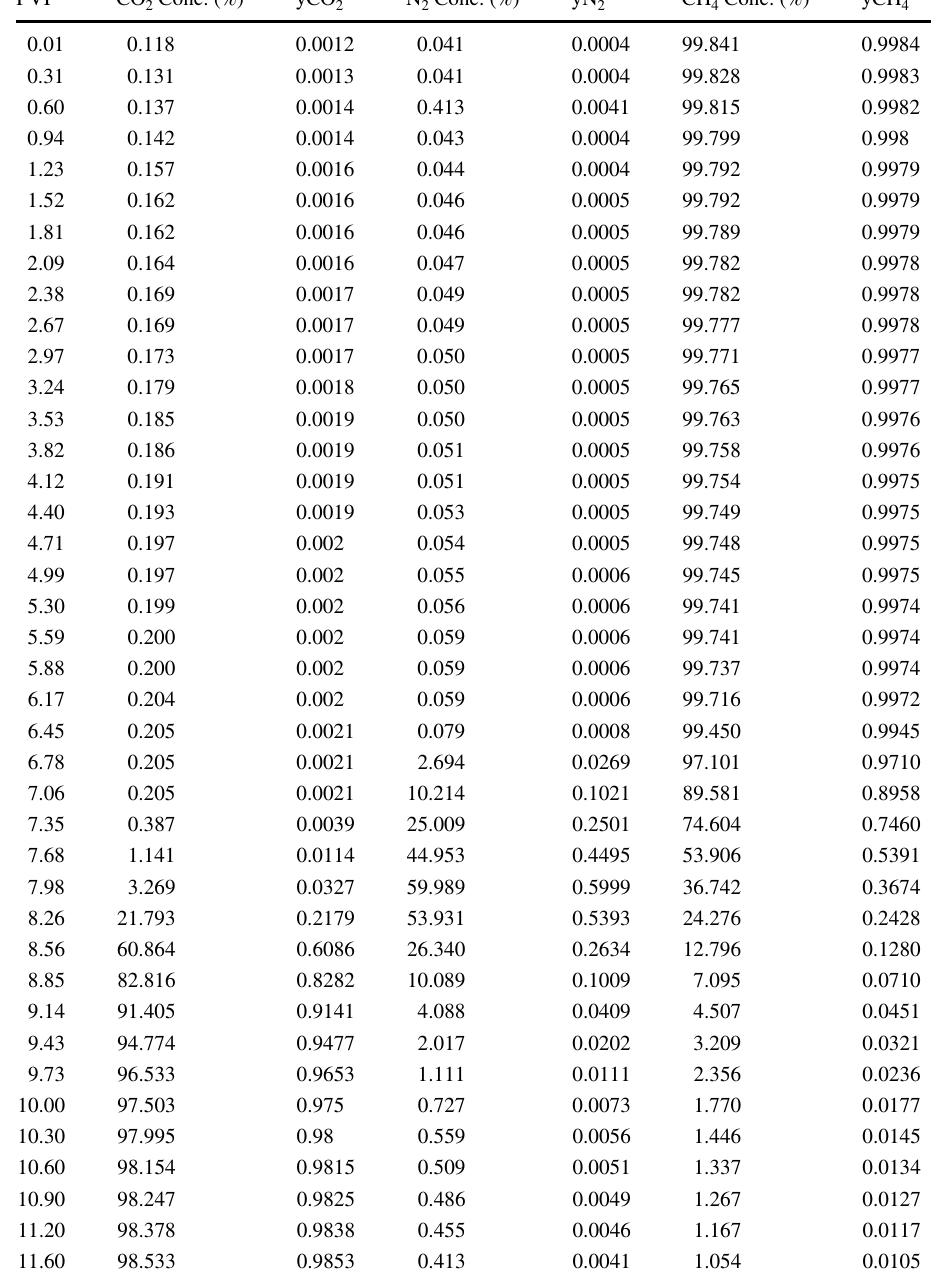
Table 8 Effluent concentrations at 3 PV of cushion gas